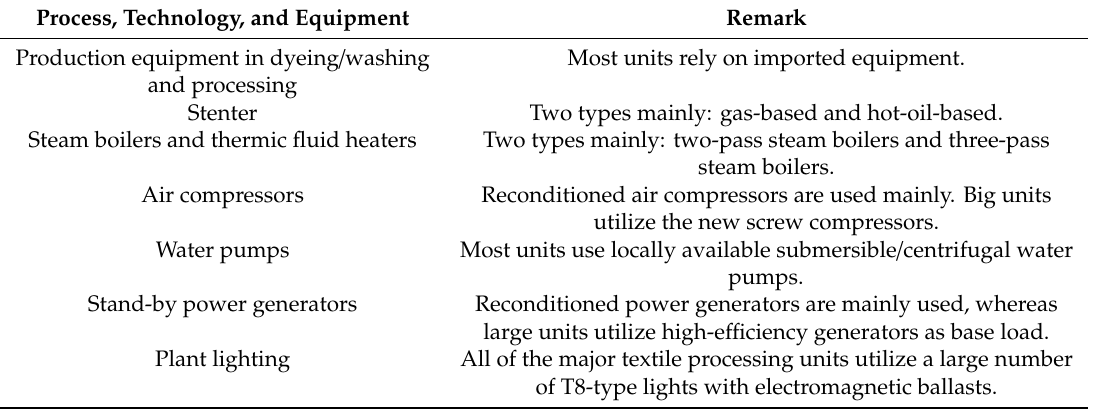
Table 3. Process, technology, and equipment in the textile industry in Bangladesh [33–35]. Process, Technology, and